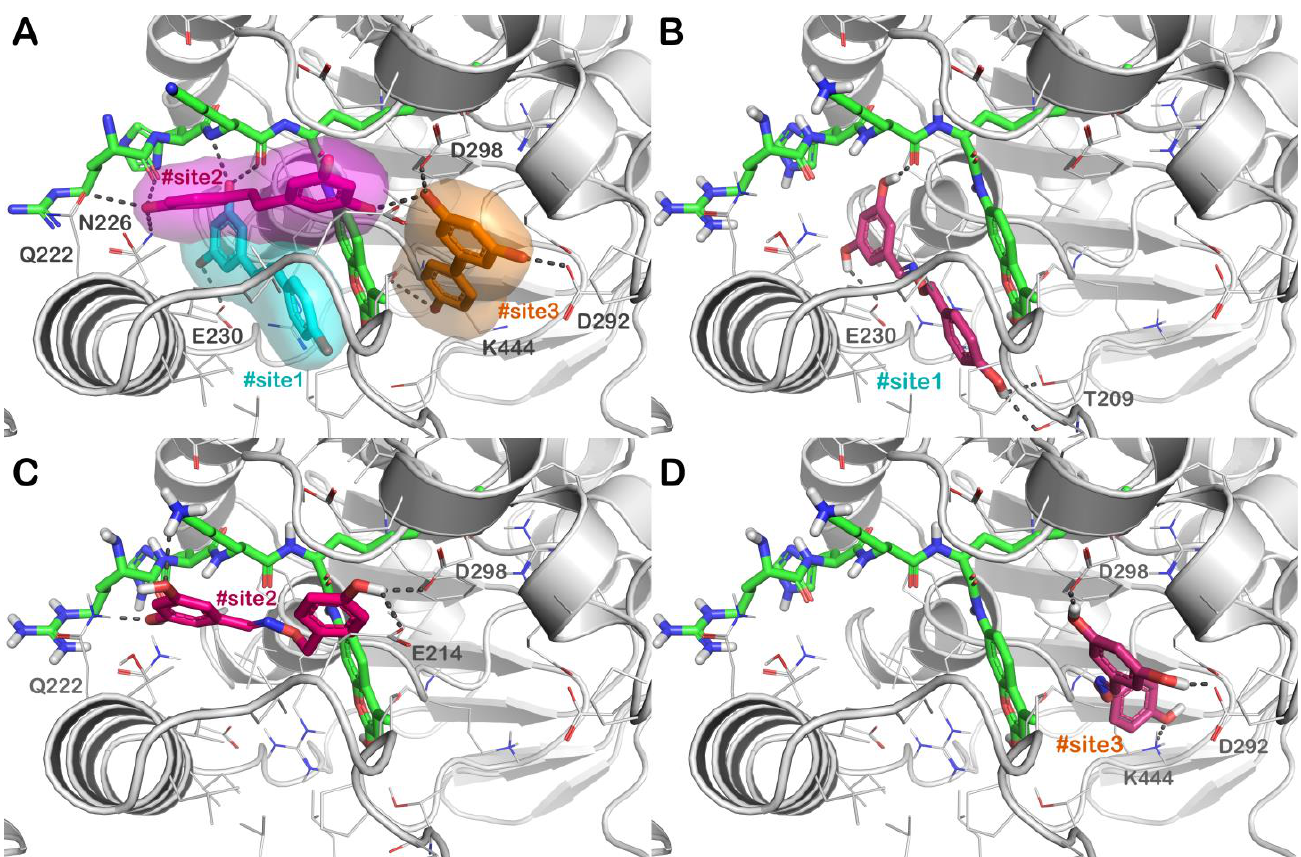
Figure 3. ( A ) Crystal structure of SIRT1 (grey cartoon representation) in complex with resveratrol (sticks representation) (PDB ID 5BTR); the different binding sites of resveratrol, namely, #site1, #site2, and #site3 are represented in cyan, magenta, and orange, respectively; ( B – D ) binding mode of compound 3d (dark purple sticks) into SIRT1 with particular focus on #site1 (panel B ), #site2 (panel C ) and #site3 (panel D ). The p53-AMC-peptide is reported as green sticks. Residues in the binding sites are represented by lines while hydrogen bonds are shown as grey dotted lines. Pictures were generated by PyMOL software (The PyMOL Molecular Graphics System, v1.8; Schrödinger, LLC, New York, NY, USA,